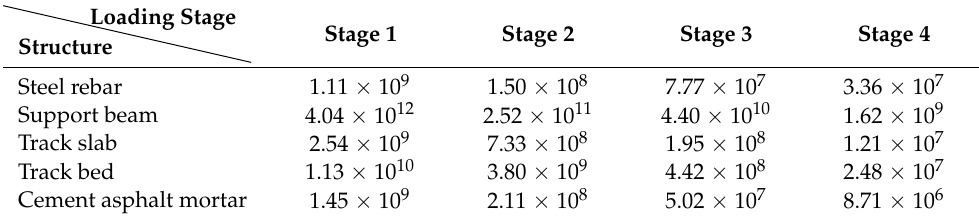
Table 4. Fatigue life of different materials.